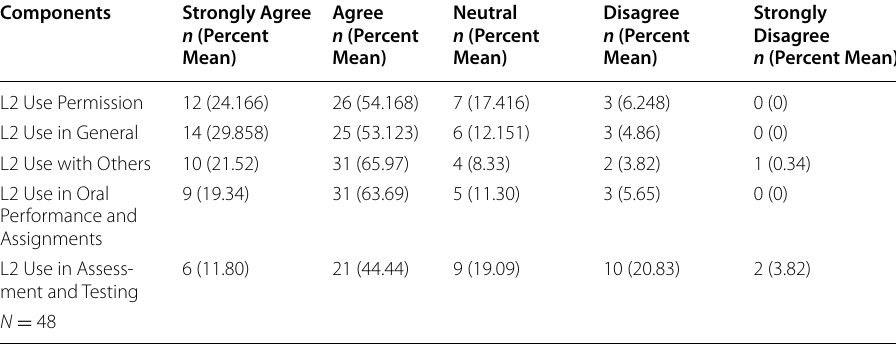
Table 17 Percent Mean for the Five Categories of the L2 Perceptions Questionnaire Components Strongly Agree n (Percent